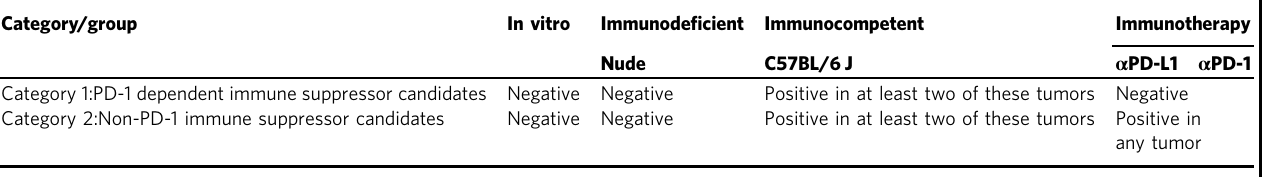
Table 2 Filter criteria for hotspot mutation pro fi